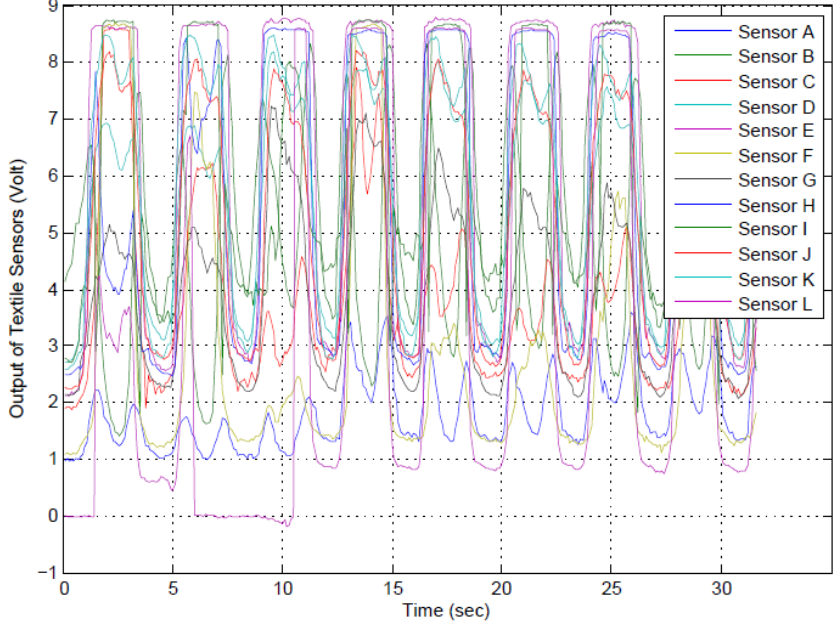
Figure 10. A sample diagram of 10 cycles for left multiplanar movement as performed by Participant 2. All sensors’ signals were adjusted to start from 1 V by potentiometers. The participant halted for a few seconds in extreme points. Therefore, a plateau can be seen for each cycle around 8.5 V.